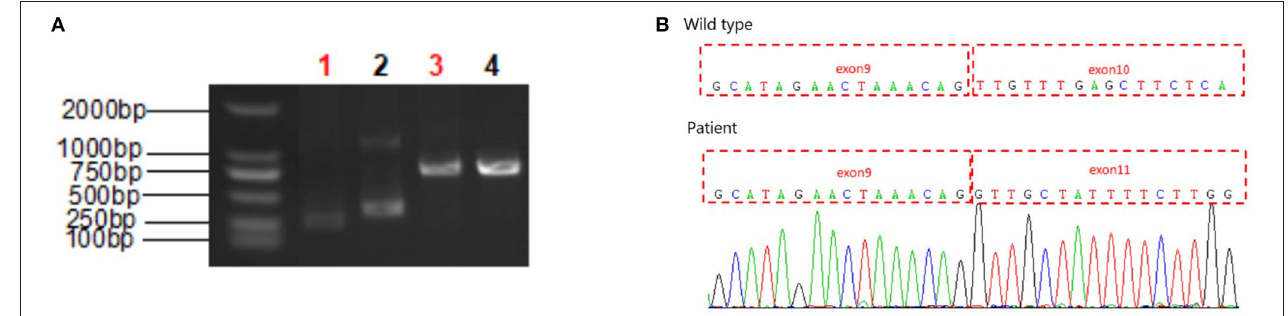
FIGURE 3 | RT-PCR analysis of the proband. (A) RT-PCR electrophoresis products on agarose gel. Lane 1: SLC9A6 gene amplification in proband’s sample, Lane 2: SLC9A6 gene amplification in normal sample, Lane 3: Reference gene amplification in proband’s sample, Lane 4: Reference gene amplification in normal sample. SLC9A6 gene mRNA expression in peripheral blood cells. (B) Sequencing analysis. A skipped exon 10 showed in proband’s cDNA compared to the sequencing analysis of a wild type sample.